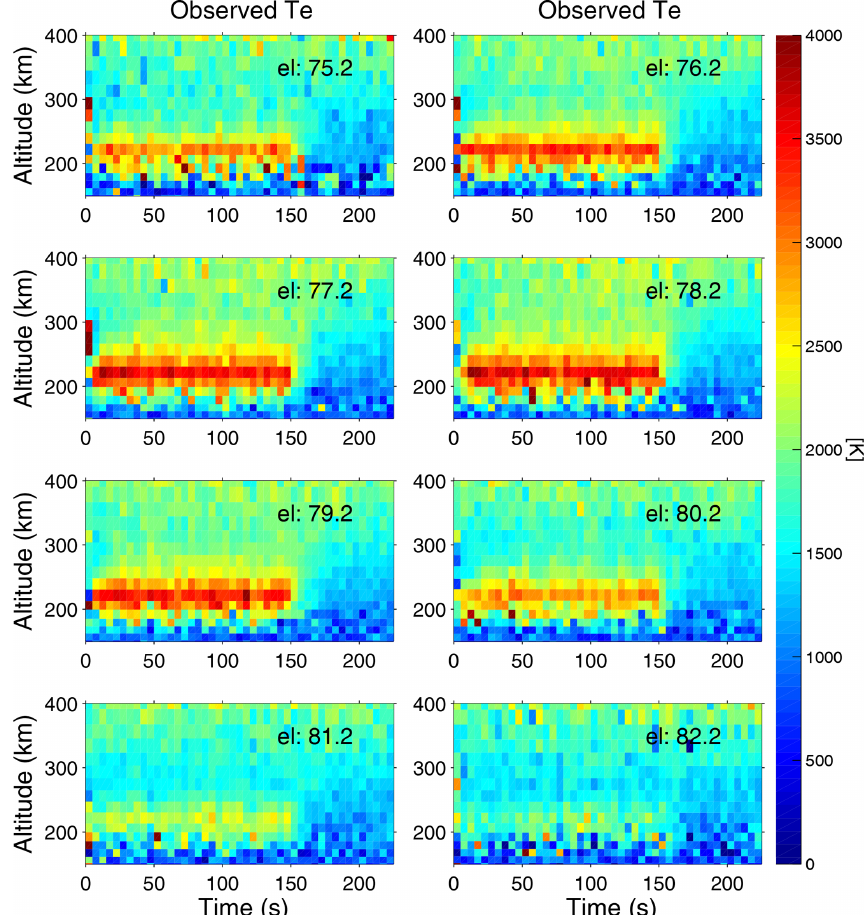
Figure 2. Height profiles of (cid:101) T e (colour coded) versus time for the different elevation angles of the UHF radar between 75.2 and 82.2 ◦ on 25 November 2014 (11:03:45–13:00:00UT). Pump-on was from t = 0 to t =